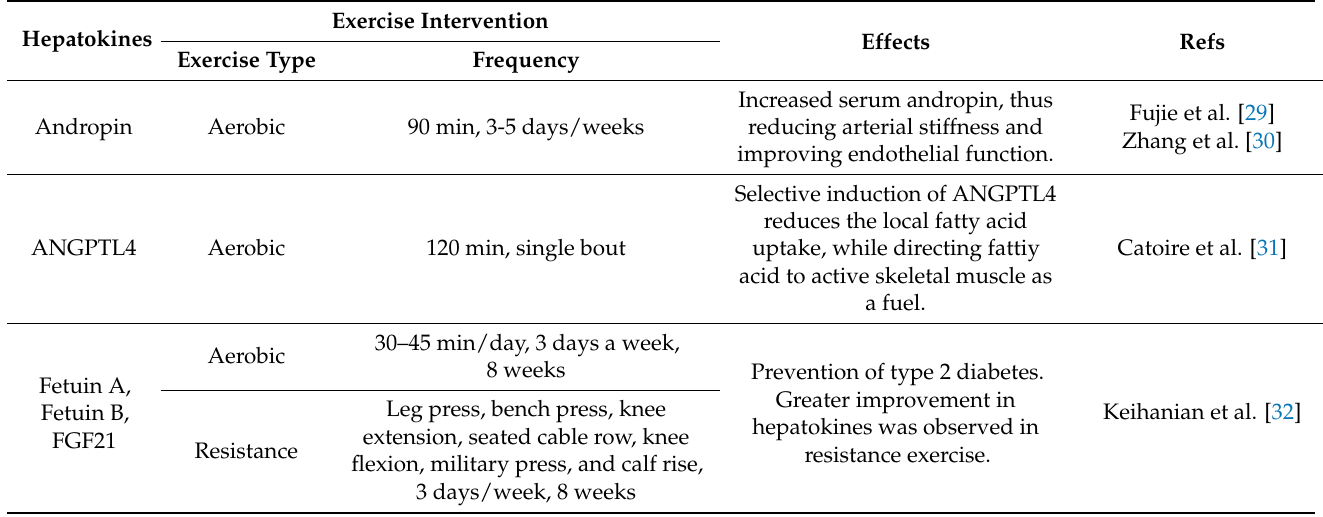
Table 2. Effects of exercise interventions on